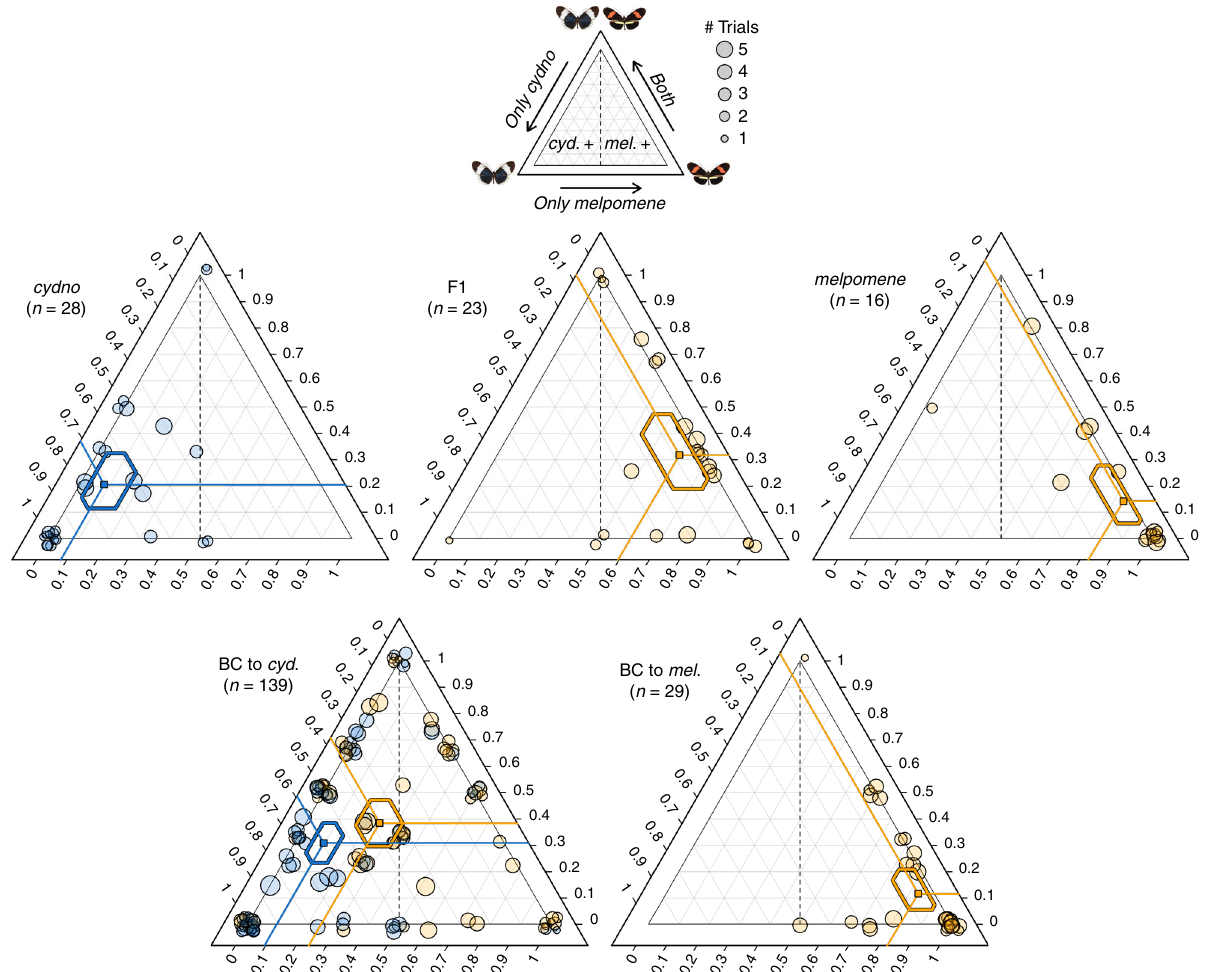
Fig. 1 Genotype at the QTL on chromosome 18 in fl uences courtship initiation. Ternary plots showing the proportion of 15-min choice trials in which single male individuals initiated courtship towards H. melpomene, H. cydno or both females. Left ternary axis shows the proportion of trials where courtship was initiated towards H. cydno female only, bottom axis towards H. melpomene female only, and right axis towards both female species. Trials without male response were removed from the dataset. Each point represents a single individual and the location of the point in the triangle is a way of representing these three proportions at once. Lines project the three predicted proportions to corresponding values on the three axes and 95% credibility intervals (CrIs) for these proportions are shown as hexagons. Orange points represent individuals that have inherited at least one H. melpomene derived allele at the preference QTL on chromosome 18 (i.e., either melp / melp or cyd / melp) ; and blue points represent individuals that are homozygous for H. cydno alleles at the preference QTL on chromosome 18 (i.e. cyd / cyd ). Point size is scaled to the number of trials in which the male showed a response and a ‘ jitter ’ function has been applied (leading to some dots being jittered to outside the